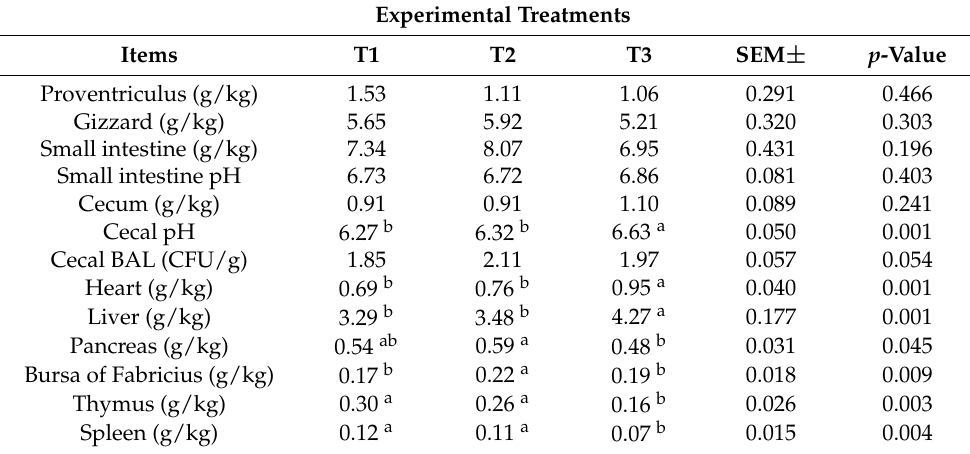
Table 4. Effect of acetic acid and sodium bicarbonate supplemented to drinking water on relative organ weights, intestinal pH and cecal lactic acid bacteria of young broilers (10 days). Experimental Treatments